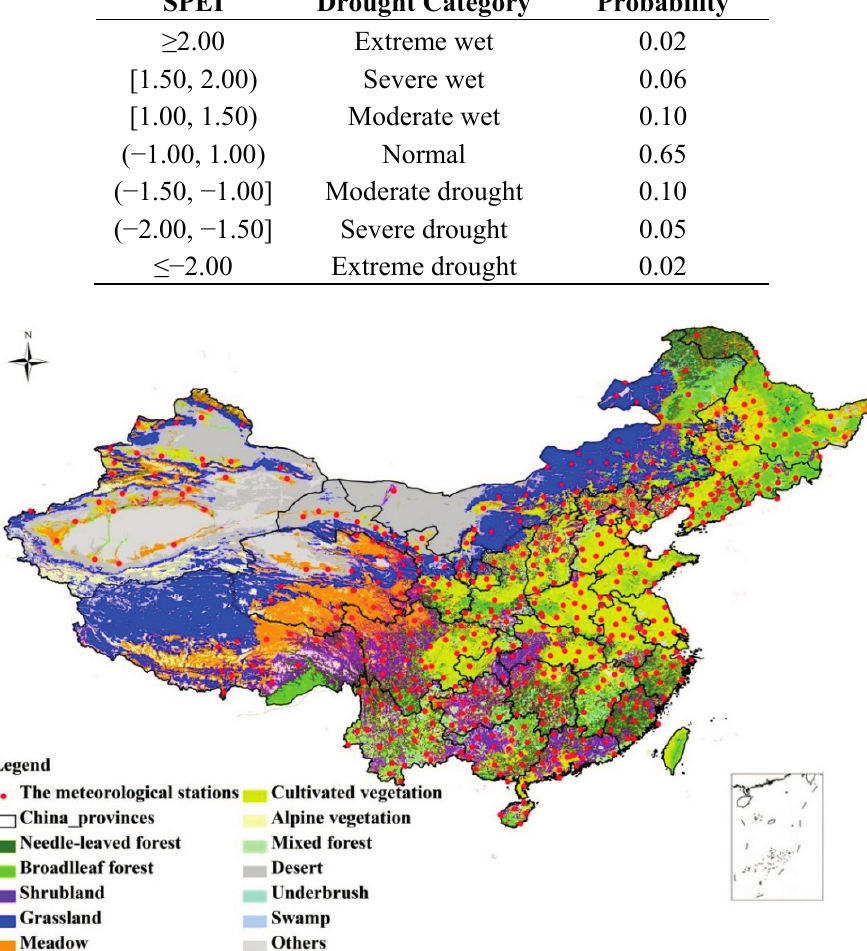
Figure 1. The distribution of the meteorological stations and the major vegetation types of